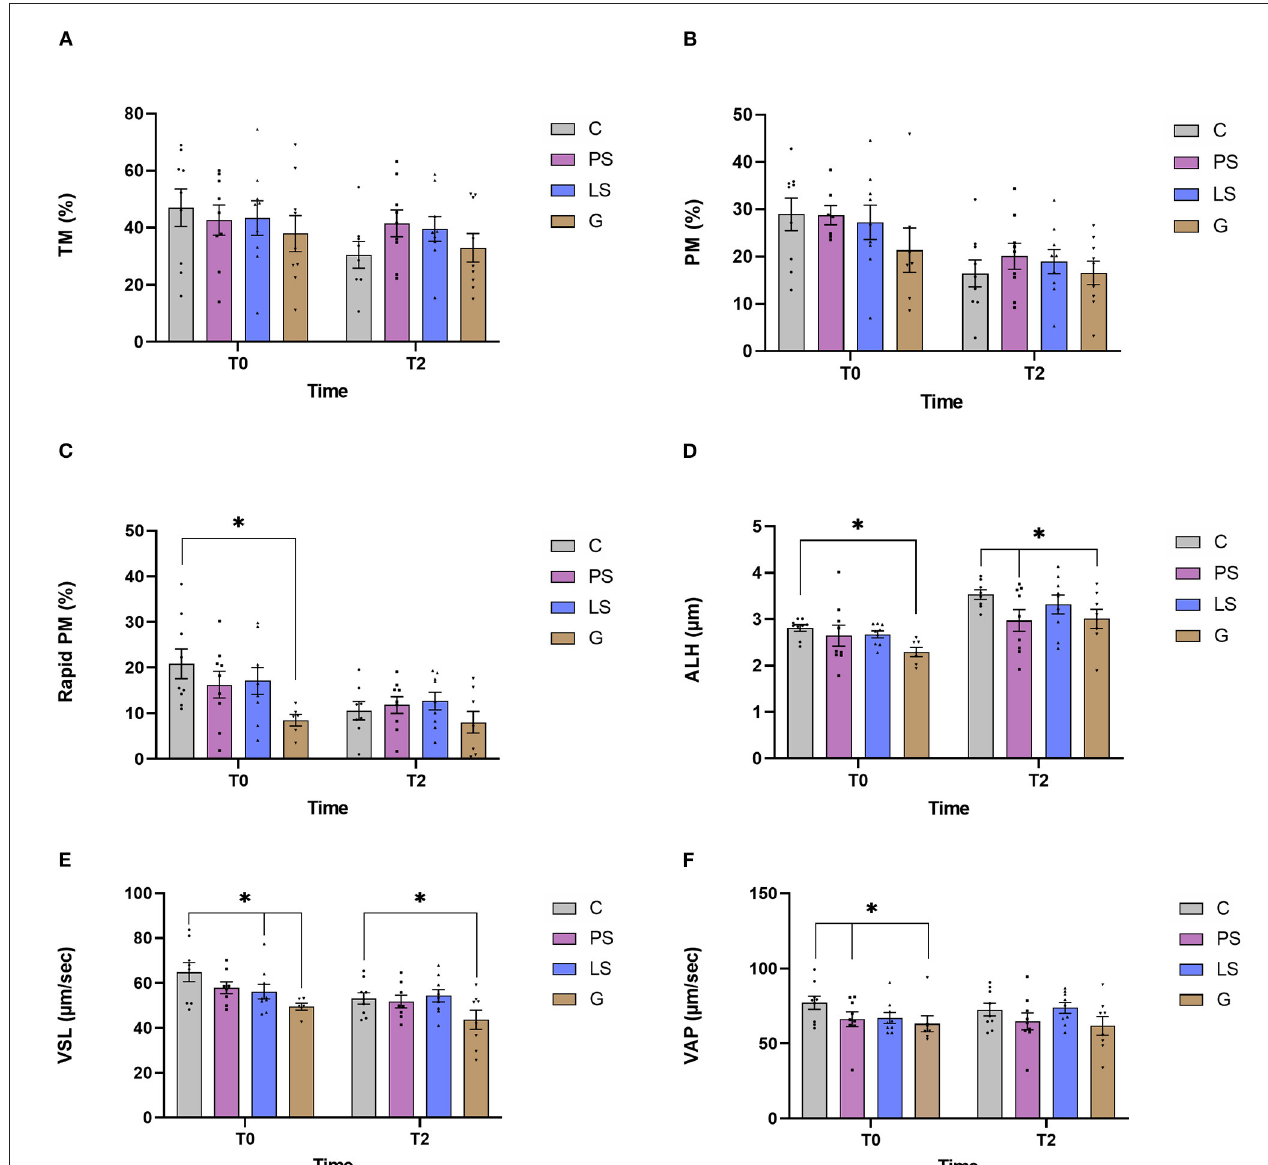
FIGURE 1 | Ram sperm motility data in the four experimental groups by time (just after thawing -T0- and after 2h of incubation at 37 ◦ C -T2-): Control (C), without antibiotics; Penicillin-Streptomycin (PS); (500 UI) − 625 µ g/mL, respectively; Lincomycin-Spectinomycin (LS); 300–600 µ g/mL respectively; and Gentamicin (G) 1,000 µ g/mL. (A) Total motility (TM, %); (B) progressive motility (PM, %); (C) rapid progressive motile sperm (Rapid PM, %), (D) amplitude of the lateral head movement (ALH, µ m), (E) velocity according to the straight path (VSL, µ m/s), and (F) velocity according to the smoothed path (VAP, µ m/s). Nine males were analyzed (1 ejaculate per male) including the same males in each experimental group. Graph dots represent individual male ejaculate. Significant differences ( P < 0.05) are represented with an asterisk between the antibiotic treatment and the Control sample without antibiotics.